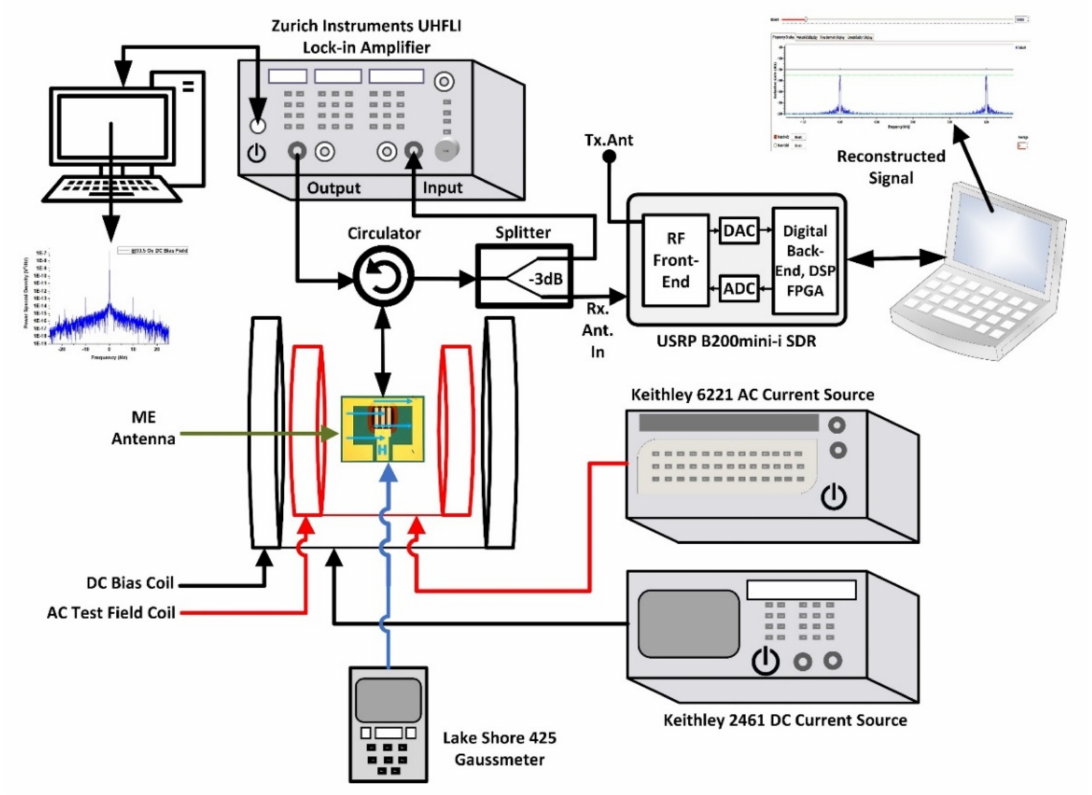
Figure 3. Test setup for the SDR receiver operation with the ME antenna as a magnetic field